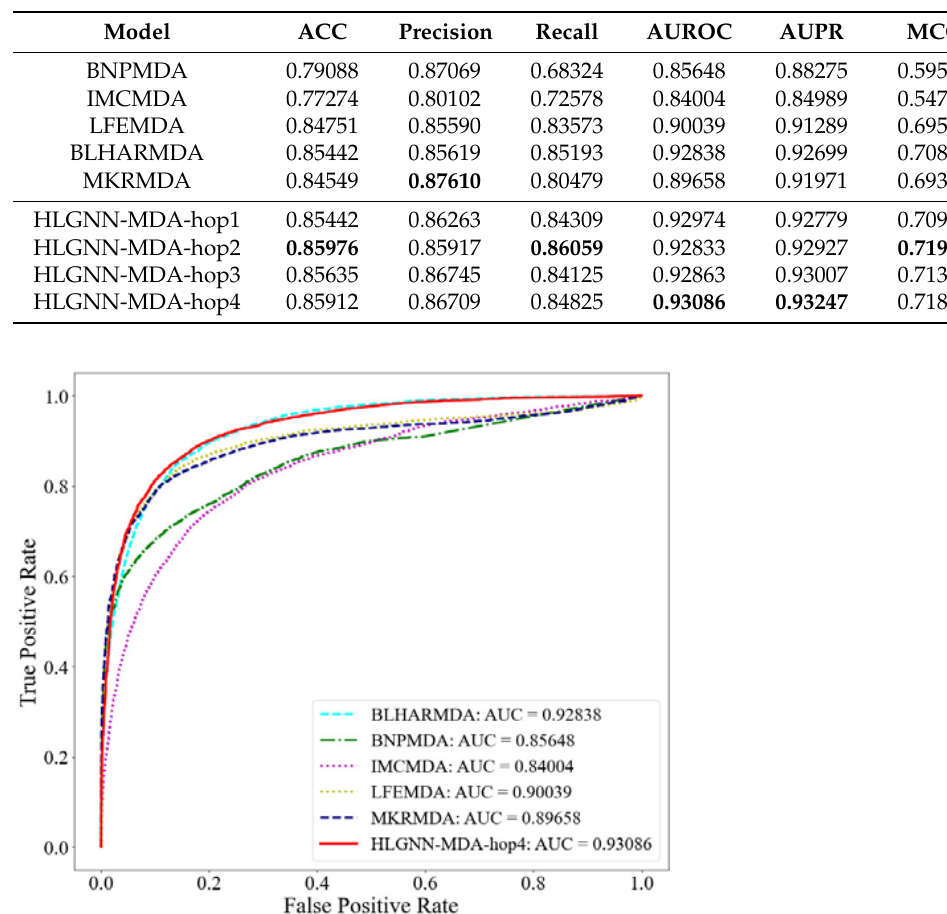
Figure 4. ROC curve of HLGNN-MDA and state-of-the-art miRNA–disease association prediction algorithms.